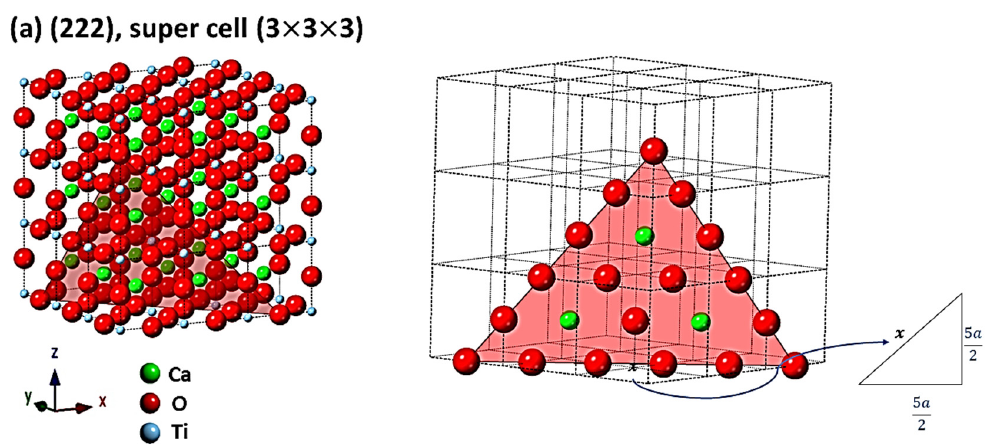
Figure 5. The concept of a symmetry cell; geometry of planes and calculations of planar density of ( a ) (311) super cell (3 ×